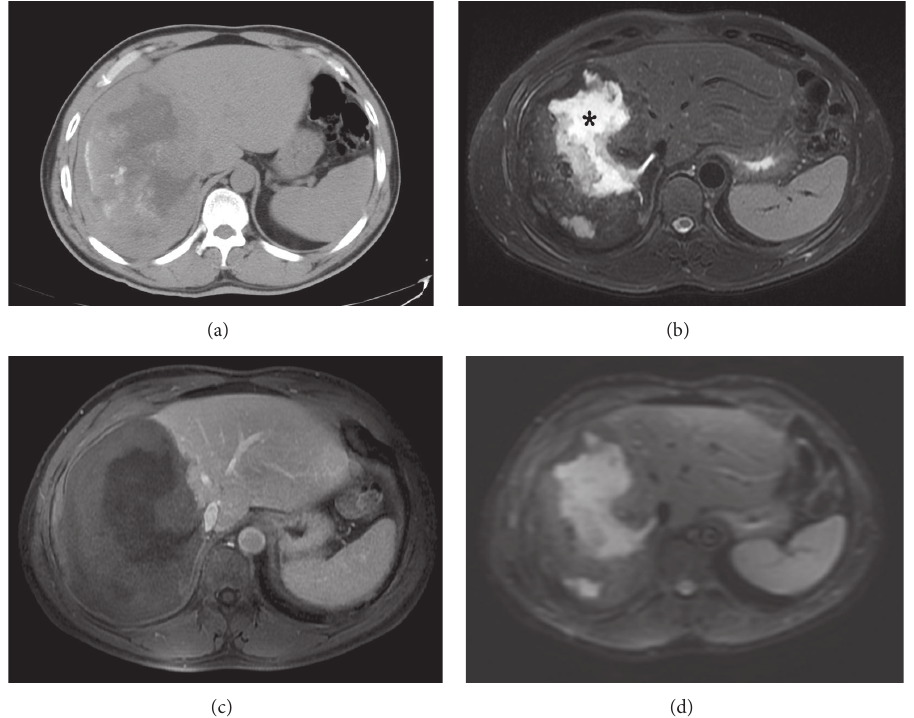
Figure 1: Unenhanced CT scan shows an infiltrating hepatic solid mass that contains multiple cystic-necrotic hypodense areas and hyperattenuating foci of internal calcifications (a). Necrotic areas (asterisk) of the mass are clearly seen in an axial T2-weighted fast recovery fast spin echo (FRFSE) image (b). Gadolinium-enhanced T1-weighted gradient-echo, dynamic 3D-liver acquisition with volume acceleration (LAVA) image depicts no contrast enhancement in the lesion (c). Relative to the surrounding liver parenchyma, the central areas of the mass remain hyperintense on the diffusion-weighted ( 𝑏 value = 500 s/mm 2 ) spin echo-echo planar imaging (SE-EPI) image (d).